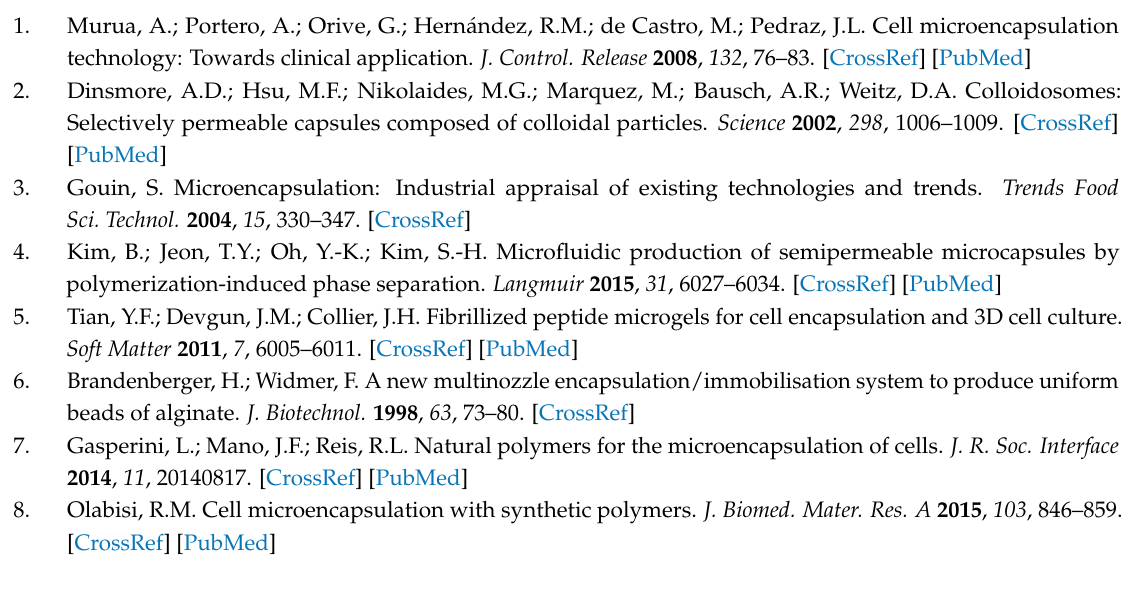
Figure S1: SEM images of the CaCO 3 crystals formed at each concentration, Figure S2: The confocal microscope images scanned at different depth of cell-embedded CaCO 3 crystals (1.4 mg/mL cell and 50 mM CaCl 2 /Na 2 CO 3 ), Figure S3: Optical microscope images of CaCO 3 crystals formed in the presence of microalgal cells with a negatively charged PSS outermost coating (PAH/PSS) 1 , Figure S4: Optical microscope images showing that most crystals contain microalgal